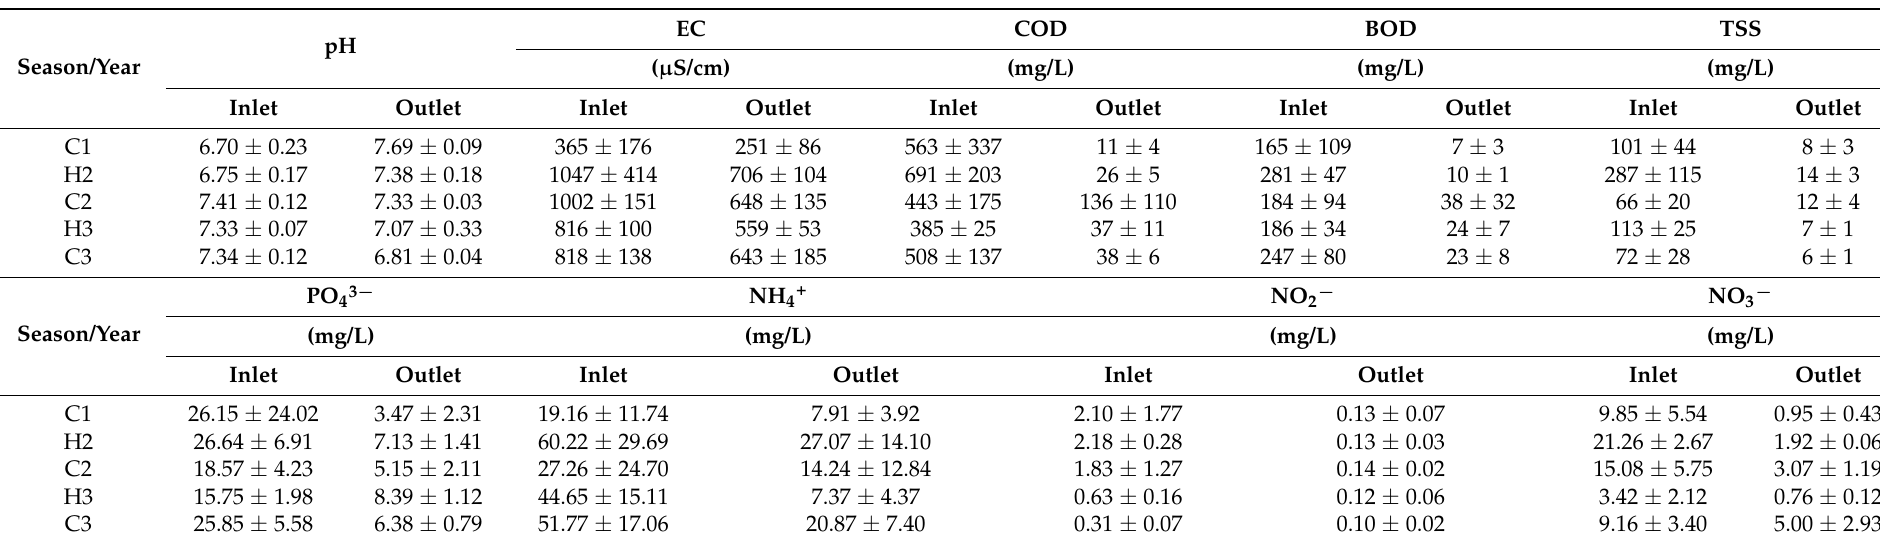
Table 1. Inlet and outlet composition of the wastewater from the constructed wetland during cold (C) and hot (H) seasons across three consecutive years (1, 2, 3). Values are mean ± standard error (n = 4 for each